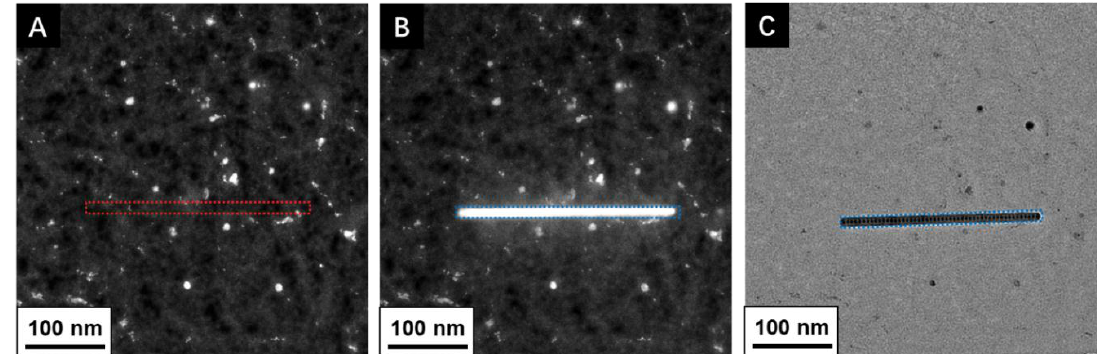
Figure 2. S/TEM images showing amorphous carbon deposited on graphene using electron beam induced deposition (EBID) in the scanning probe mode (STEM). ( A ) STEM image of graphene substrate. The red box indicates the line scanning position to be deposited (STEM mode). ( B , C ) the blue box shows formation amorphous carbon at the scanned line position (high contrast); B STEM image and C TEM image. Data collected on a FEI Titan Themis 3 with Cs correction for the objective lens at 80 kV.